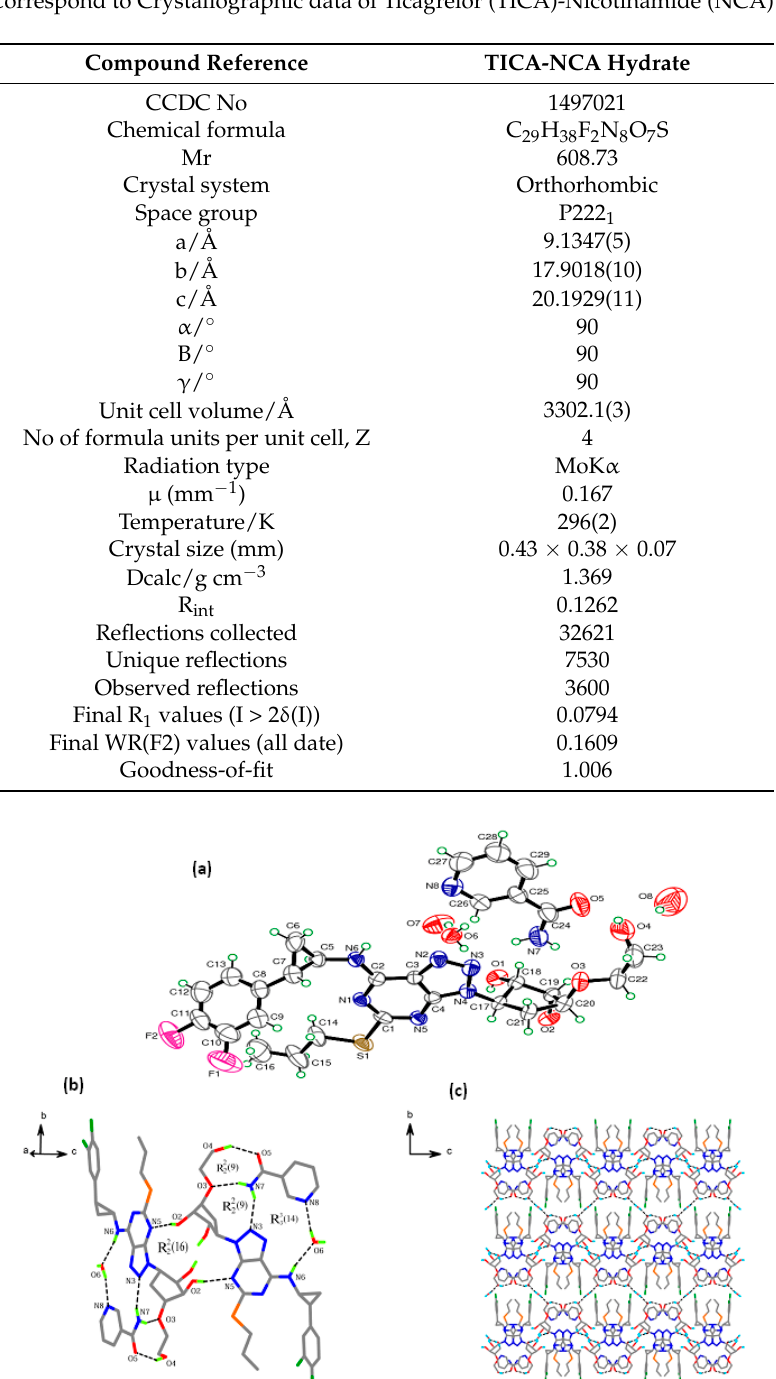
Table 1. Correspond to Crystallographic data of Ticagrelor (TICA)-Nicotinamide (NCA) hydrate.